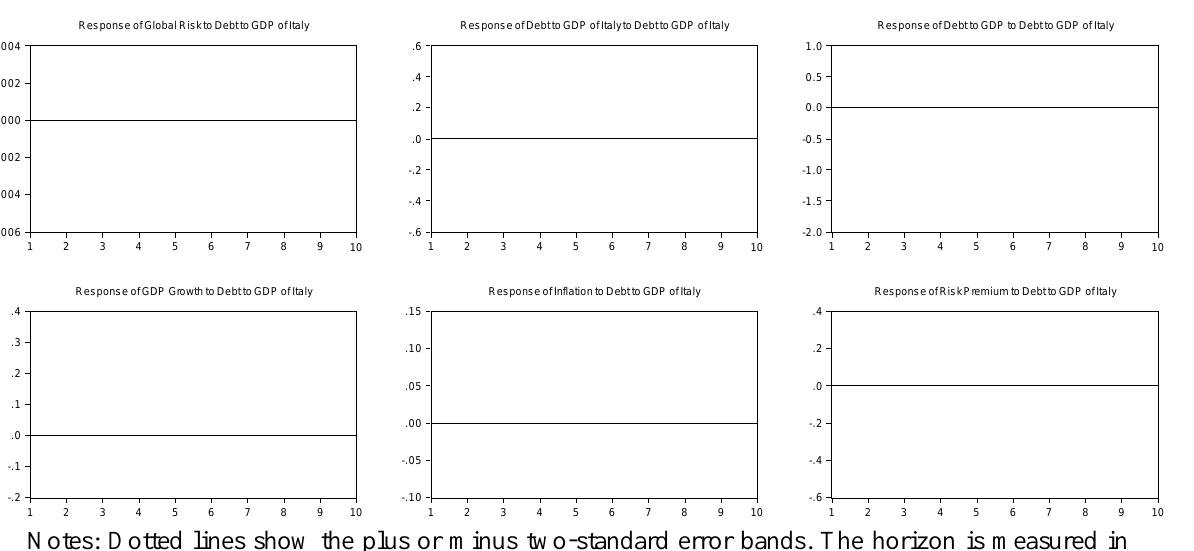
Figure 18. Response of EMU countries to a shock to Italy’s debt-to-GDP ratio during the crisis: